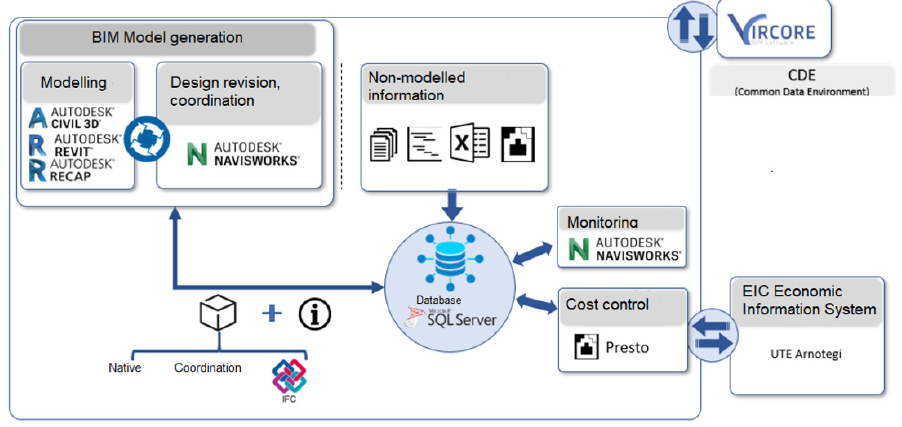
Figure 13. Detail of nomenclature assignment of different parts of the model. Definition of the no ‐ menclature of the forward pass “PE” and the destroy pass